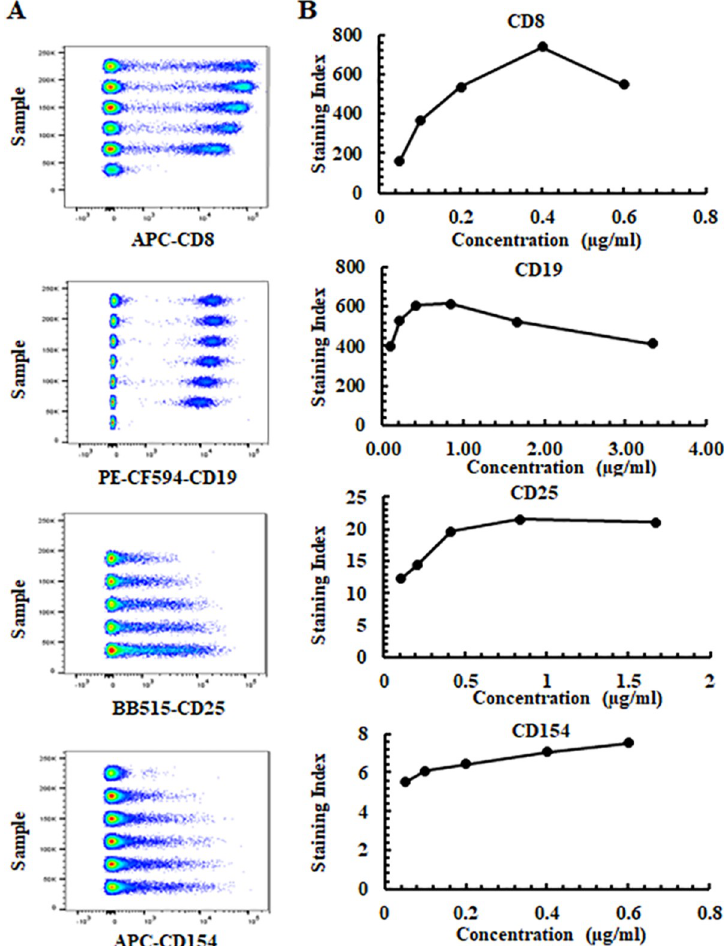
Fig 2. Four representative fluorochrome-conjugated antibody titrations. (A) Concatenated pseudocolor data at 5–6 antibody concentrations for APC-CD8 (RPA-T8), PE-CF594-CD19 (HIB19), BB515-CD25 (2A3) and APC-CD154 (TRAP1) . (B) Staining indexes and antibody concentrations for APC-CD8, PE-CF594-CD19, BB515-CD25 and APC-CD154. APC-CD8, PE-CF594-CD19, BB515-CD25 were assessed on lymphocytes (excluding CD4+ cells), lymphocytes or CD3+CD4+ T cells respectively. APC-CD154 was evaluated on CD3+CD4+ T cells of PBMCs that were activated with CD3/CD28 beads overnight. The final antibody concentrations used in the study for APC-CD8, PE-CF594-CD19, BB515-CD25 and APC-154 were 0.05 μ g/ml, 0.38 μ g/ml, 0.83 μ g/ml, 0.3 μ g/ml